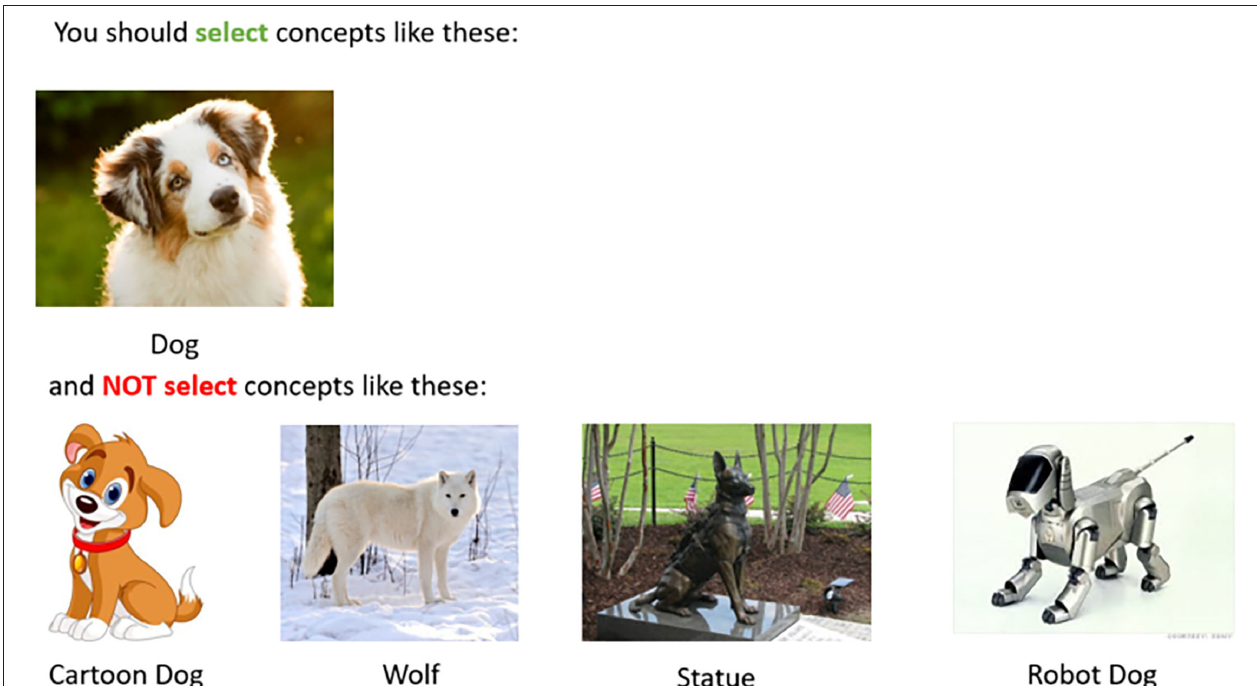
FIGURE 4 | For Stage 3 (LABEL), we combine the ambiguous instances and/or tags collected in Stage 1 (FIND) with the requester labels from Stage 2 (RESOLVE) and automatically inject the labeled examples back into task